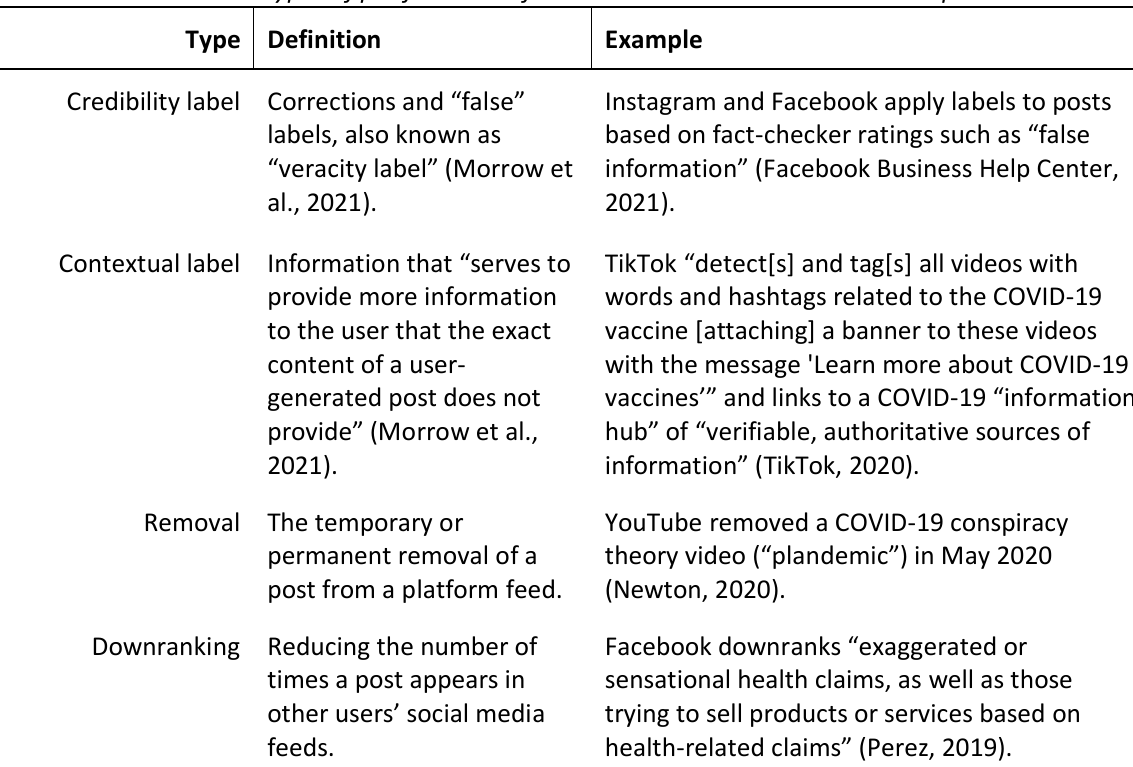
Table 1. Types of platform misinformation interventions on individual